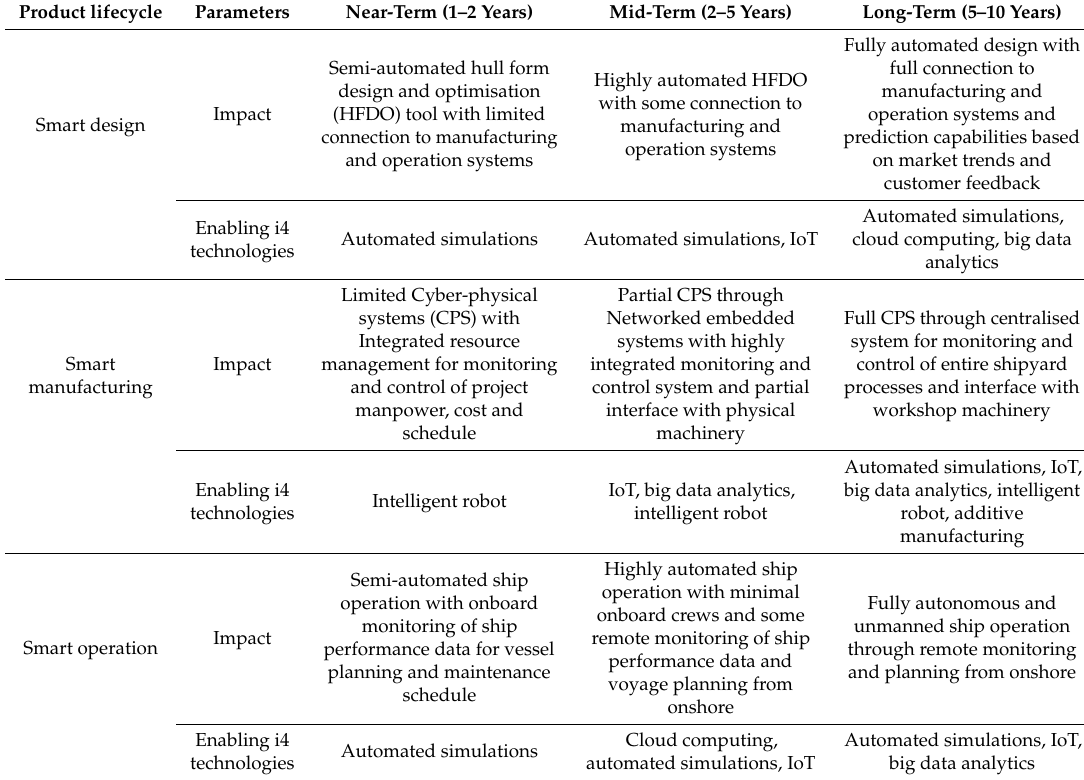
Table 3. Milestones and potential impacts for smart design, manufacturing and